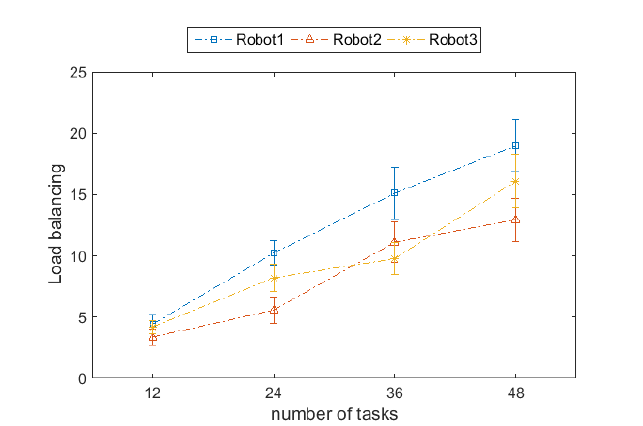
Figure 13. Average number of tasks executed per robot using